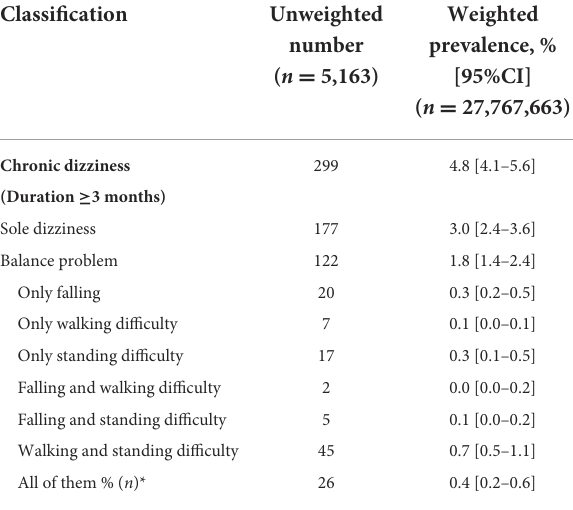
TABLE 2 Estimated prevalence of chronic dizziness in the Korean adult population.